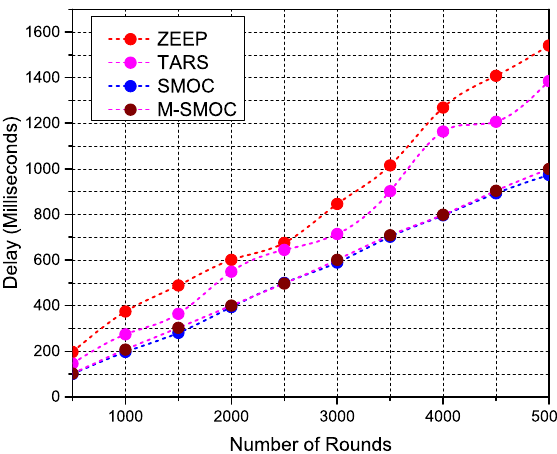
Figure 8. Comparison of the end-to-end delay with respect to the number of